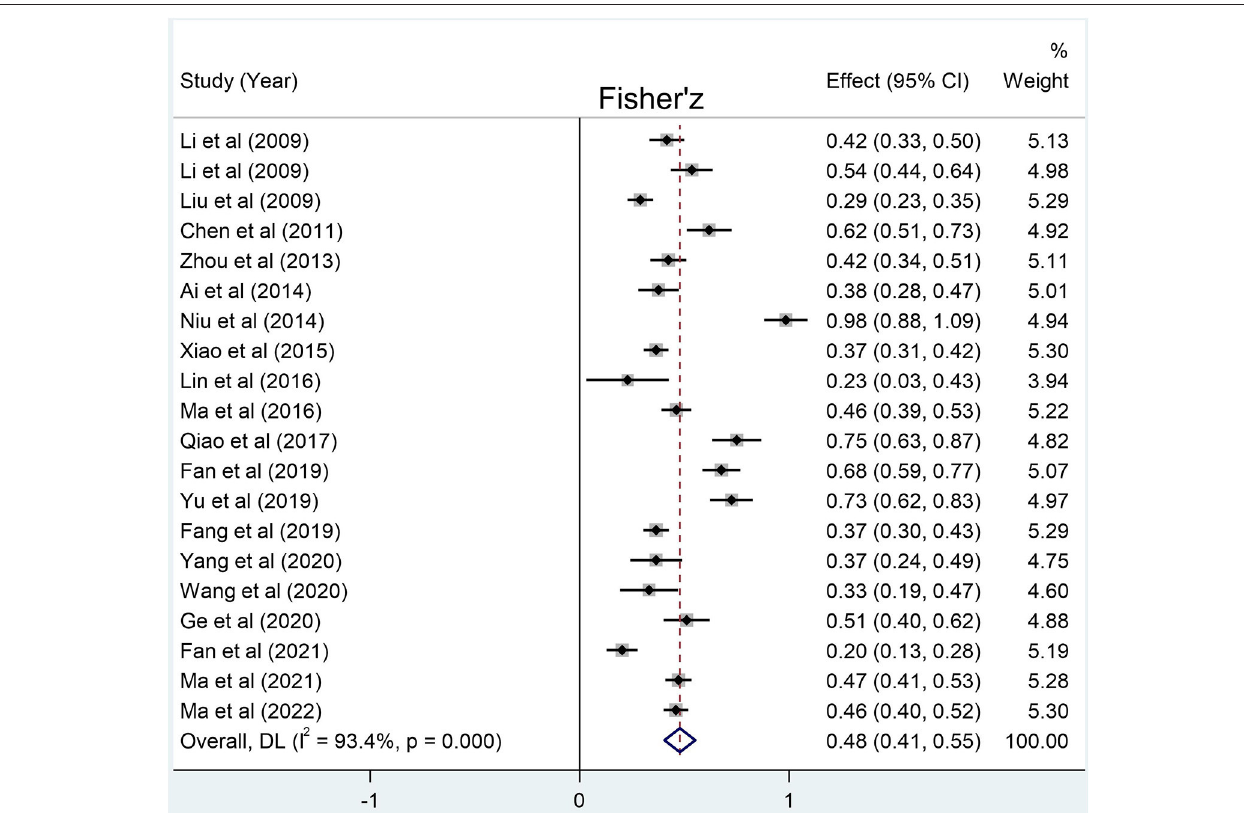
measurement tools (ULS-8: summary r = − 0.45, 95% CI: −